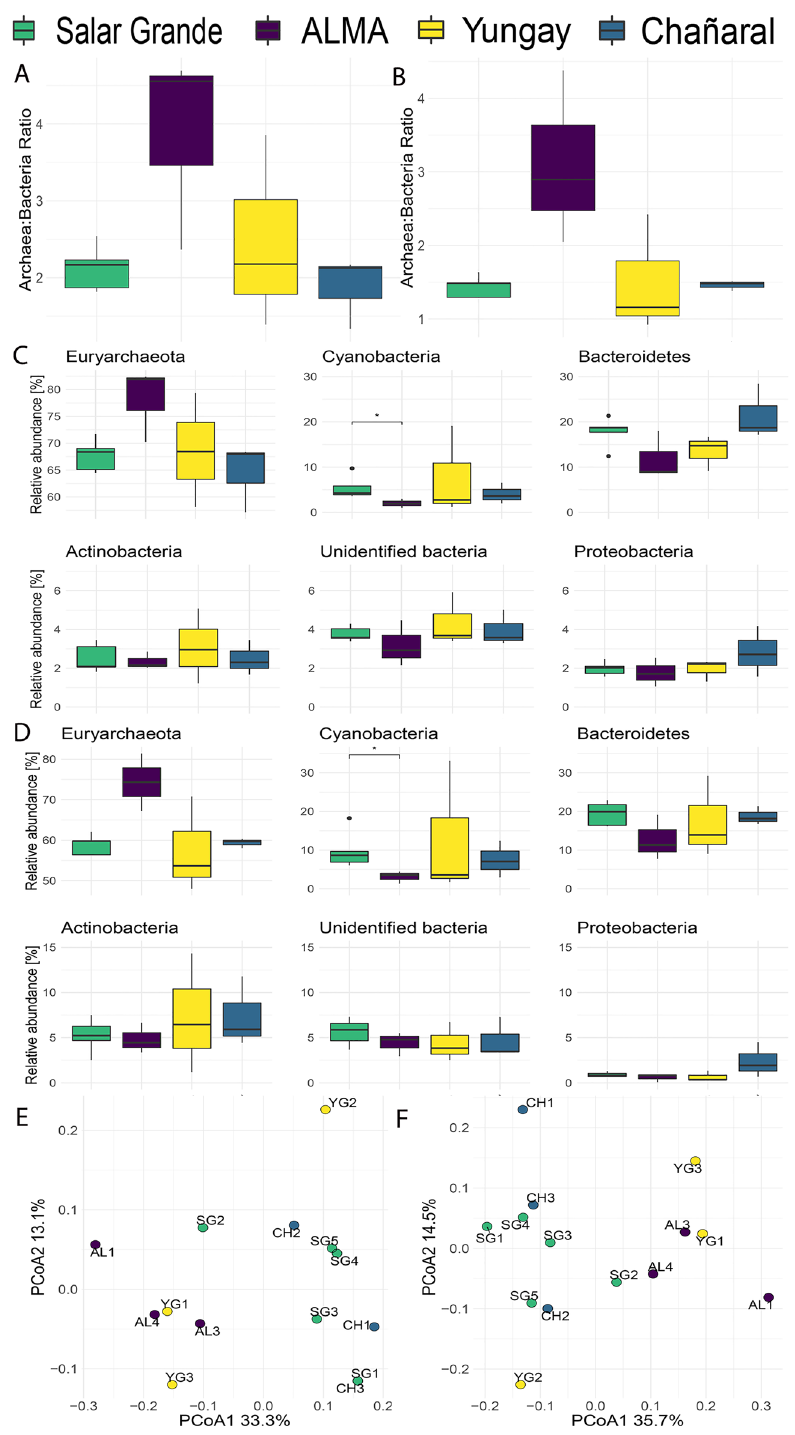
Figure 3. Relative abundances of halite microbial taxa across sites showing changes in community taxonomic composition after 1-year exposure to different environmental conditions. Archaea: bacteria ratios in ( A ) contigs and ( B ) MAGs. Relative abundances at the phylum level in ( C ) all contigs and ( D ) MAGs. Bray–Curtis distance’s ordination plots calculated on the relative abundances of ( E ) contigs and ( F ) MAGs across sites. Error bars represent standard deviation; significance bars denote Welch’s t-test p <